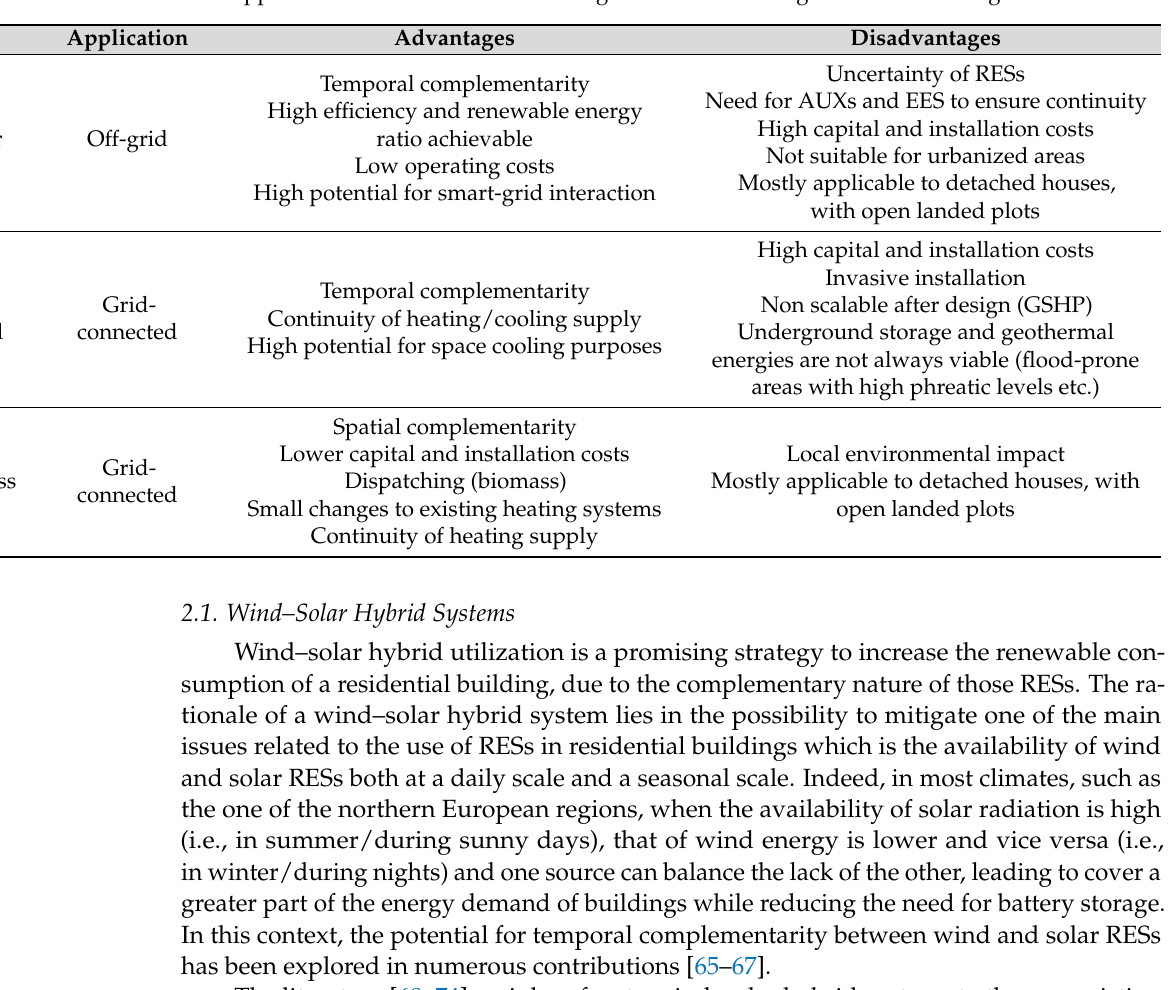
Uncertainty of RESs Need for AUXs and EES to ensure continuity High capital and installation costs Not suitable for urbanized areas Mostly applicable to detached houses, with open landed